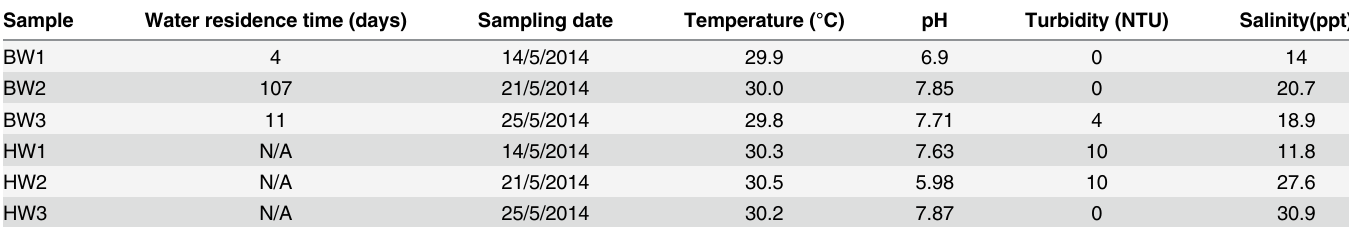
Table 5. Physical characteristics of ballast and harbor waters. Sample